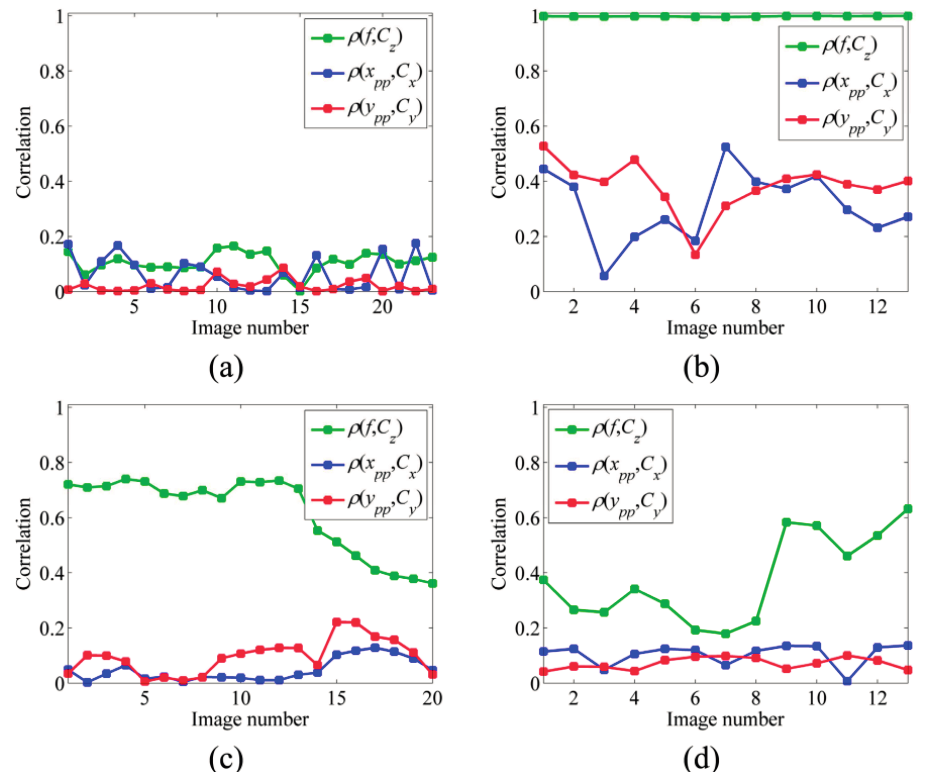
Figure 25. Correlation analysis in self-calibration based on ( a ) CalTest 1; ( b ) CalTest 2; ( c ) CalTest 3; ( d ) CalTest 2 by applying the proposed BBA